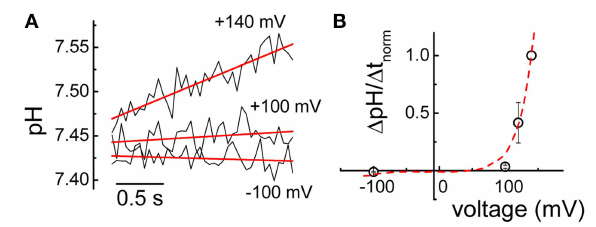
FIGURE 6 | Proton transport mediated by mutation G212A. (A) Representative alkalinization recorded at different voltages in a cell transfected with mutation G212A ClC-5 using ratiometric BCECF fluorometry. Lines represent linear fits to the data and were used to provide the rates of alkalinization 1 pH/ 1 t . (B) Averaged rates of alkalinization normalized to the value measured at + 140mV ( n = 5 ). The red line represents